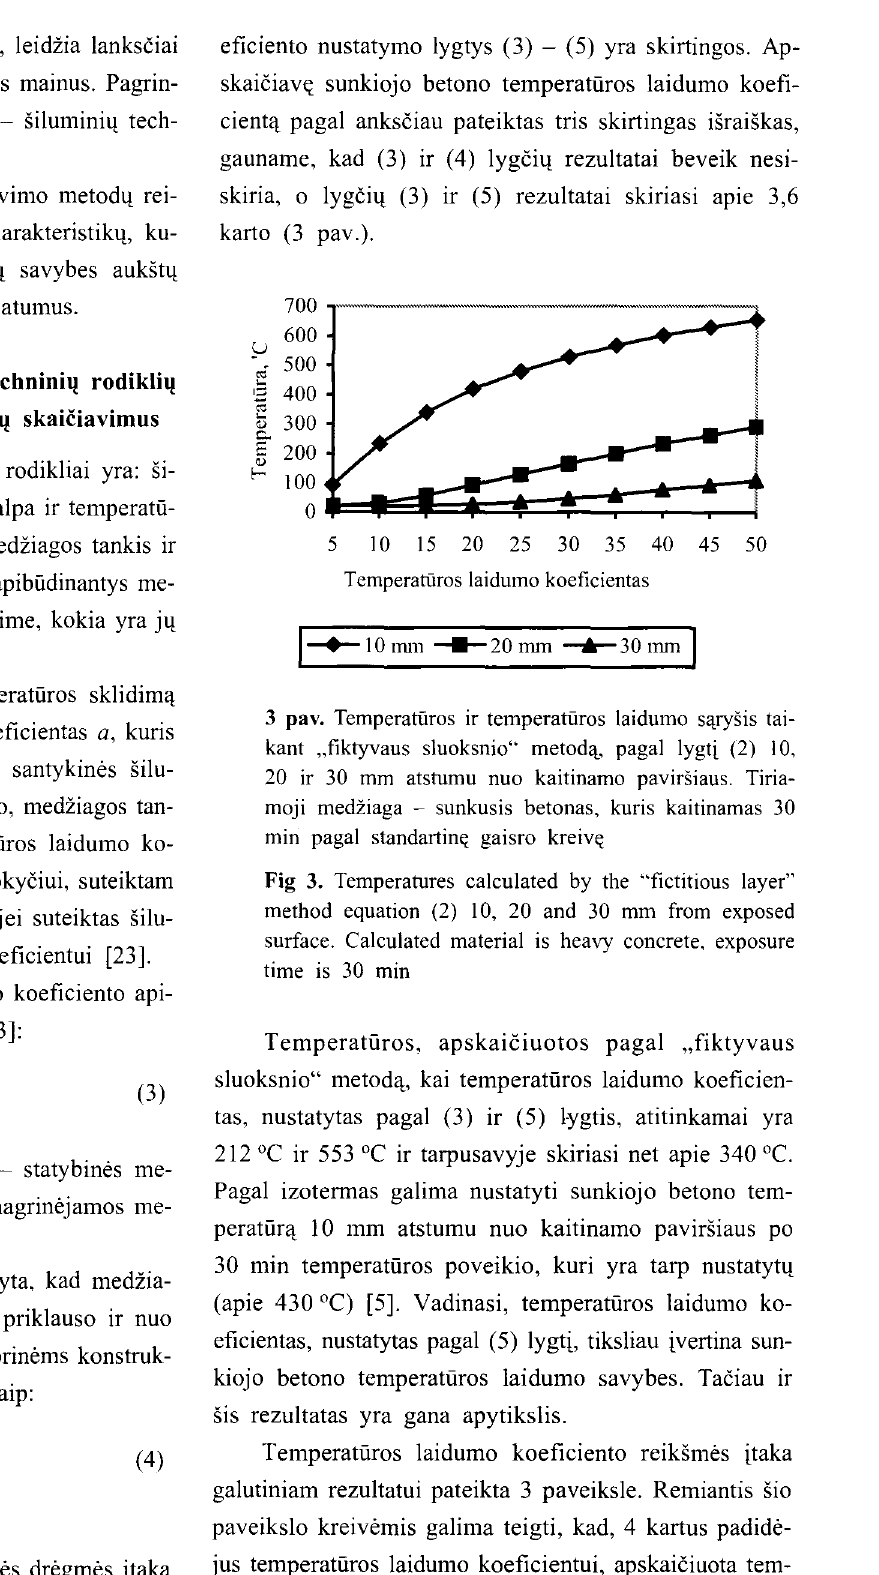
Fig 3. Temperatures calculated by the "fictitious layer" method equation (2) 10, 20 and 30 mm from exposed surface. Calculated material is heavy concrete, exposure time is 30 min Temperatiiros, apskaiciuotos pagal ,fiktyvaus sluoksnio" metod<t, kai temperatiiros laidumo koeficien tas, nustatytas pagal (3) ir (5) lygtis, atitinkamai yra Pagal izotermas galima nustatyti sunkiojo betono tem peratiir<t 10 mm atstumu nuo kaitinamo pavirsiaus po 30 min temperatiiros poveikio, kuri yra tarp nustatytl! (apie 430 °C) [5]. Vadinasi, temperatiiros laidumo ko eficientas, nustatytas pagal (5) lygti, tiksliau ivertina sun sis rezultatas yra gana